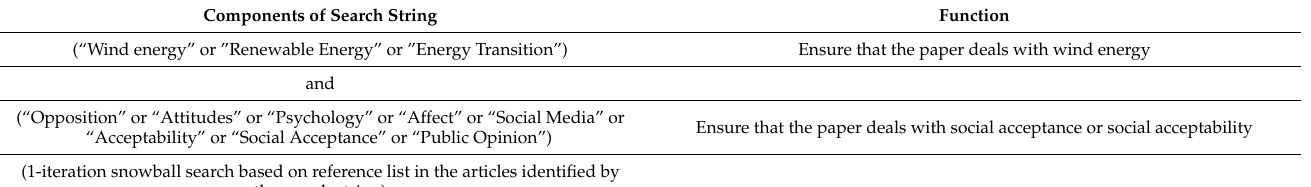
Table 1. Search strings used to identify potentially relevant articles in Google Scholar and